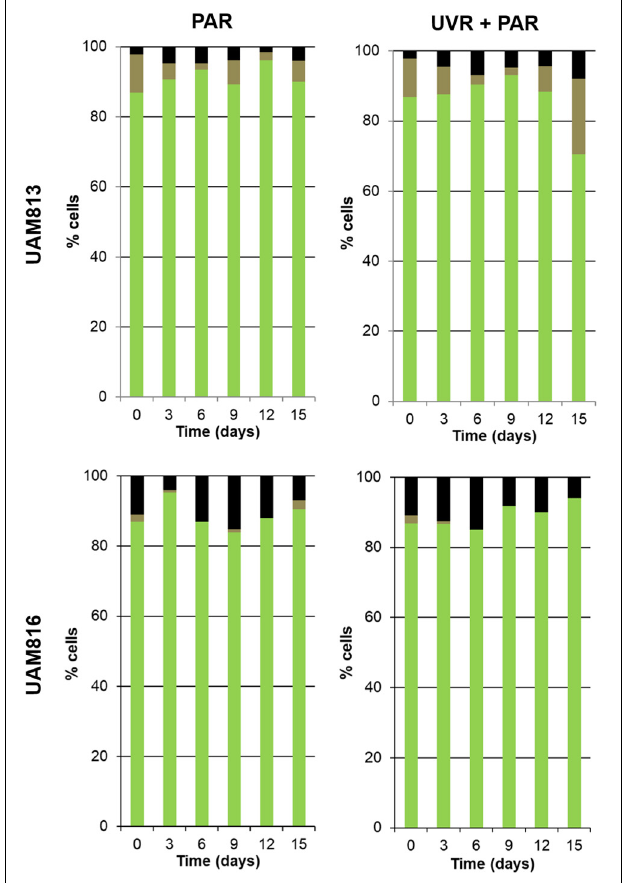
FIGURE 5 | Metabolic activity of UAM813 and UAM816 cells after irradiation with PAR (left graphs) or UVR + PAR (right graphs) for 15 days. Green: (PCHL+/CTC+) active cells. Brown: (PCHL+) damaged cells. Black: (GF+) unviable